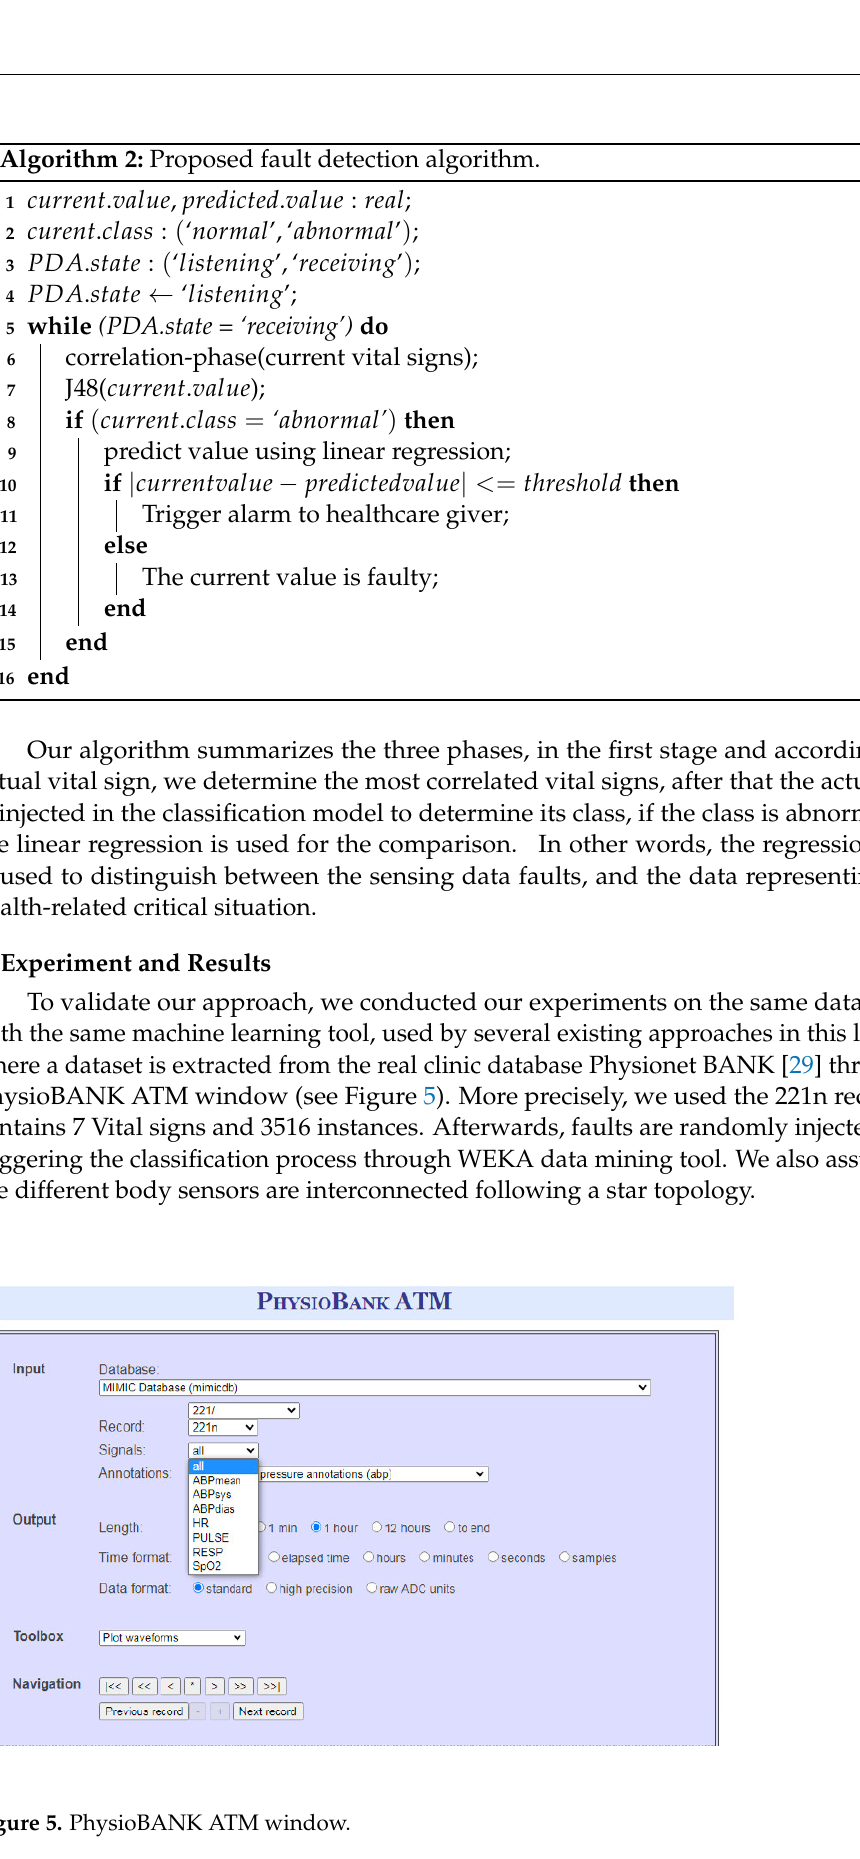
Figure 5. PhysioBANK ATM